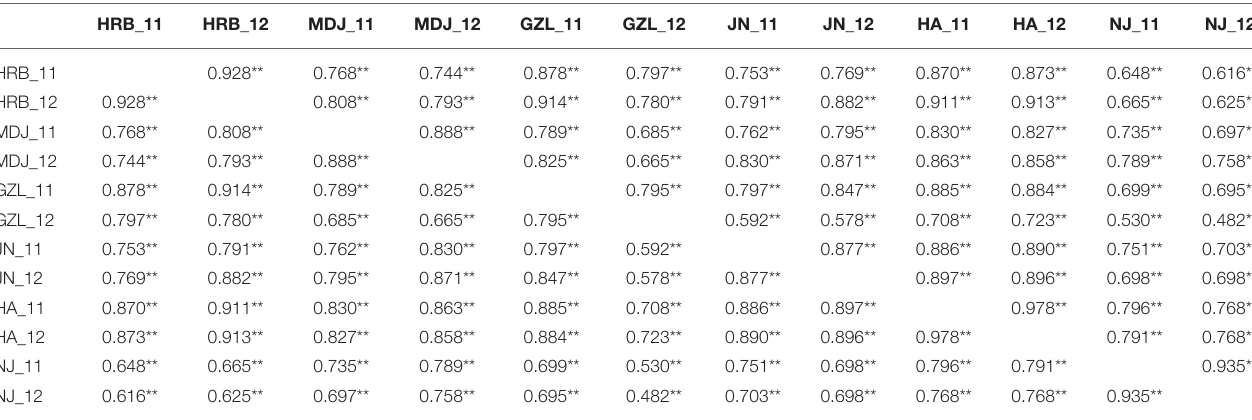
TABLE 2 | The correlation coefficients between R1 (first flower) of soybean cultivars grown at different locations in 2011 or